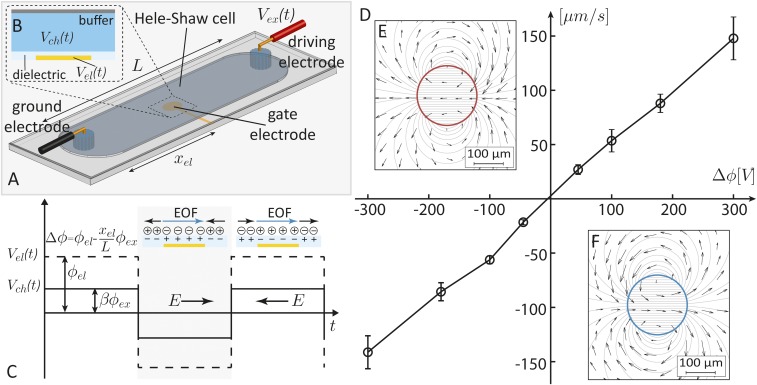
Concept of shaping EOFs by using gate electrodes in a Hele–Shaw cell. (A) Illustration of the fluidic system consisting of a Hele–Shaw cell of length L, a ground- (Left) and a driving (Right) electrode placed in two separate reservoirs, and gate electrodes placed at a distance xel from the ground electrode. (B) The gate electrode consists of a conductive layer insulated from the electrolyte in the chamber by a thin dielectric layer. (C) The potential of the driving electrode is set to a symmetric square-wave form of amplitude ϕex. The gate-electrode potential is modulated in sync with the driving potential with an amplitude ϕel, resulting in a net EOF with intensity and directionality depending on the local amplitude difference Δϕ=ϕel−(xel/L)ϕex. The wave forms are here illustrated for the case of Δϕ>0, for which the EOF is directed toward the driving electrode. (D) Experimental results showing the depth-averaged velocity as function of the applied gate potential for an electric field amplitude of ϕex/L=150V/cm as measured using a unidirectional flow configuration, as described in Materials and Methods. (E and F) Experimental (vector field) and analytical (streamlines) flow field of an EOF dipole generated by a 200-µm-diameter disc-shaped gate electrode for a negative and a positive Δϕ. Here the longest vector corresponds to a maximum velocity of 4.22 µm/s.